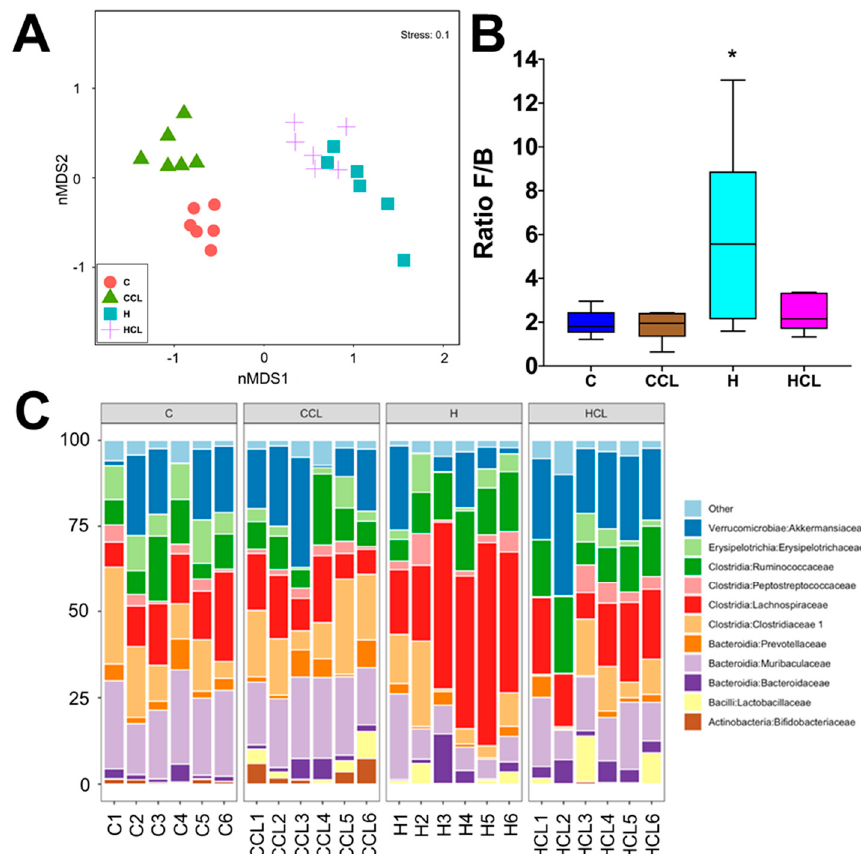
Figure 3. ( A ) Multidimensional scaling (MDS) plot of bacterial community structure of faecal samples from di ff erent feeding regimes; ( B ) E ff ect of supplementation of diet (C or H) with Caulerpa lentillifera on the ratio of Firmicutes and Bacteroidetes (F / B) abundances in rat faecal samples. Statistical analysis performed using ANOVA with Tukey’s post hoc test for multiple comparisons, * p < 0.05; and ( C ) Taxonomic profiles of bacterial communities shown at the family level of all faecal samples. C, corn starch diet-fed rats; CCL, corn starch diet-fed rats supplemented with Caulerpa lentillifera ; H, high-carbohydrate, high-fat diet-fed rats; HCL, high-carbohydrate, high-fat diet-fed rats supplemented with Caulerpa lentillifera .